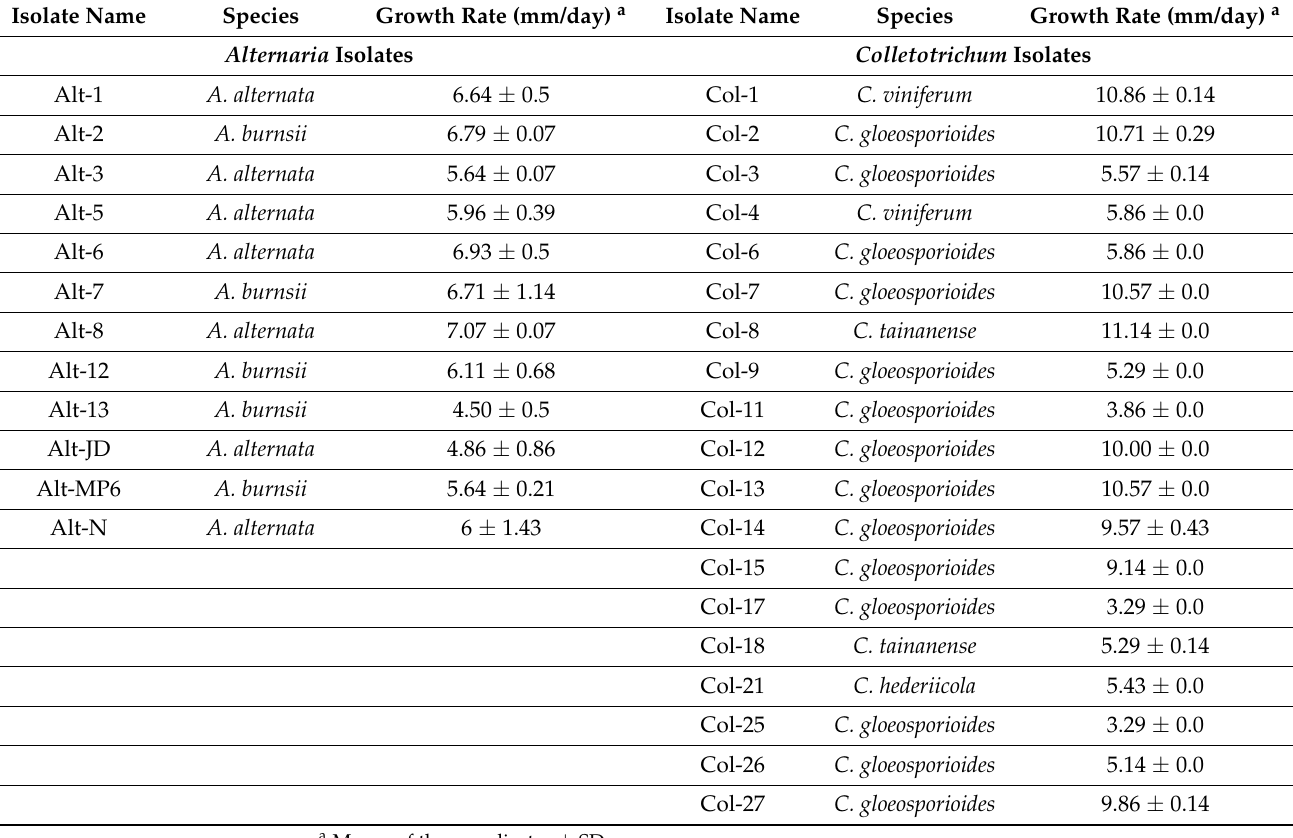
Table 4. Mean growth rate of isolates of diverse species of Alternaria ( n = 12) and Colletotrichum ( n = 19) from pomegranate characterized in this study determined after seven days incubation on PDA at 25 ◦ C.